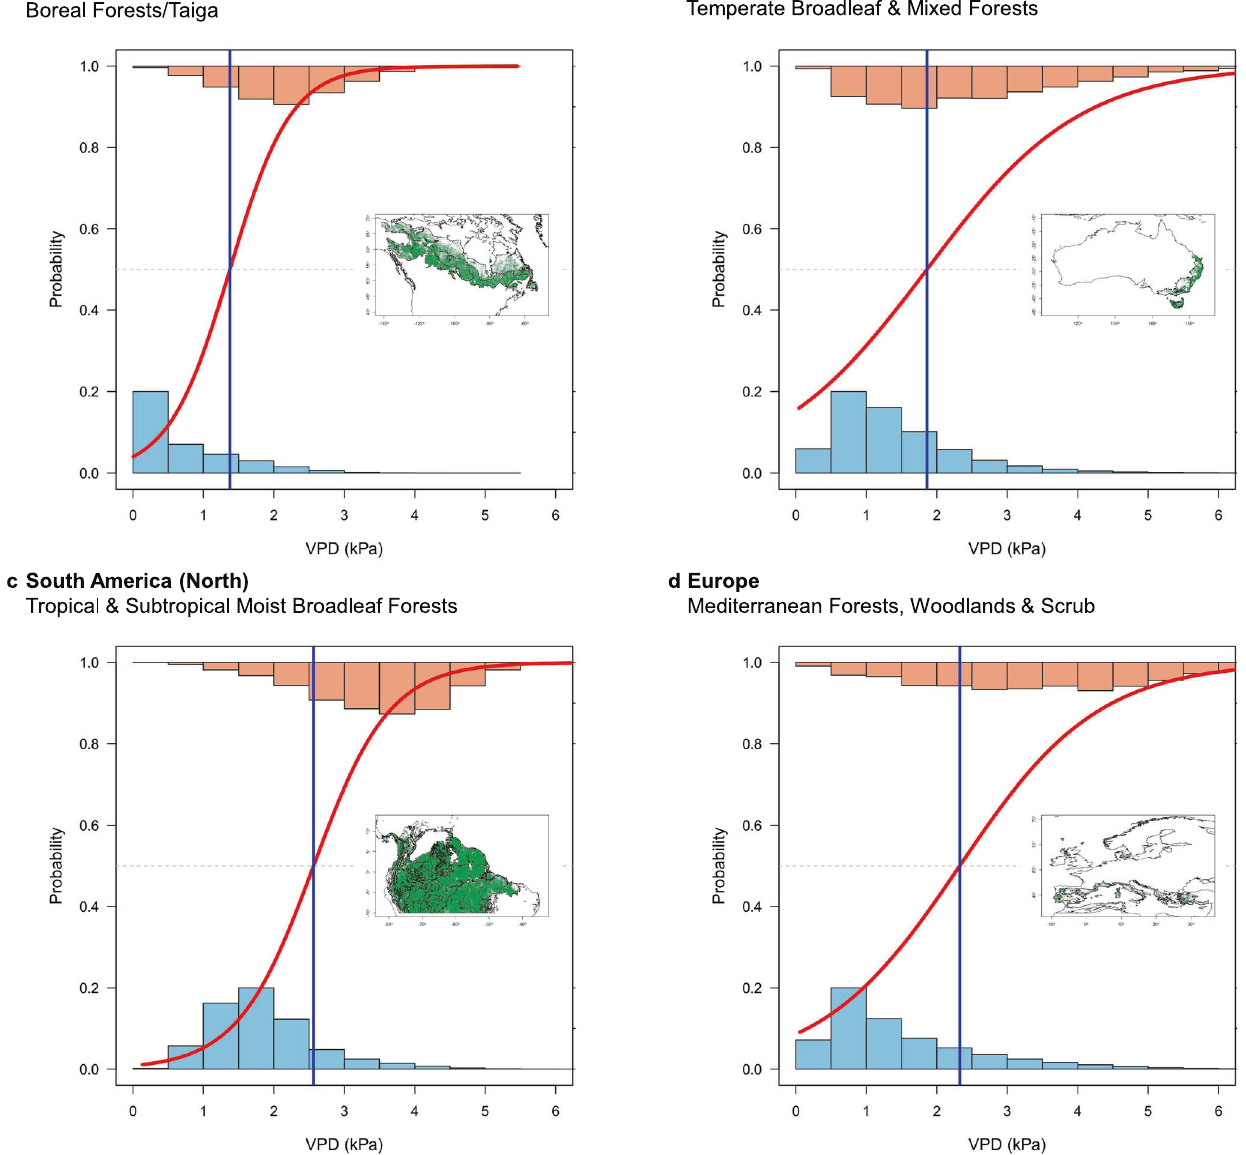
Fig. 1 | The response of forest fi re activity to VPD in four continental forest biomes.a BorealforestsandtaigainCanada( n =1,657,115). b Temperatebroadleaf and mixed forests in Australia ( n =580,200). c Tropical and subtropical moist broadleaf forests in northern South America ( n =1,697,491). d Mediterranean for- ests, woodlands and scrub in Europe ( n =147,605). The lines show generalised